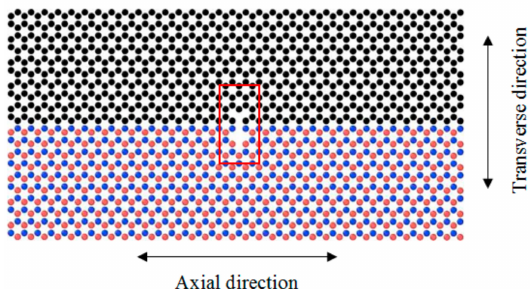
Figure 8. The vacancy defects are constructed by removing each of the B, N, and C atoms enclosed inside the red colored rectangle. The defects are then expanded along the axial or transverse direction relative to the nanosheet loading direction.